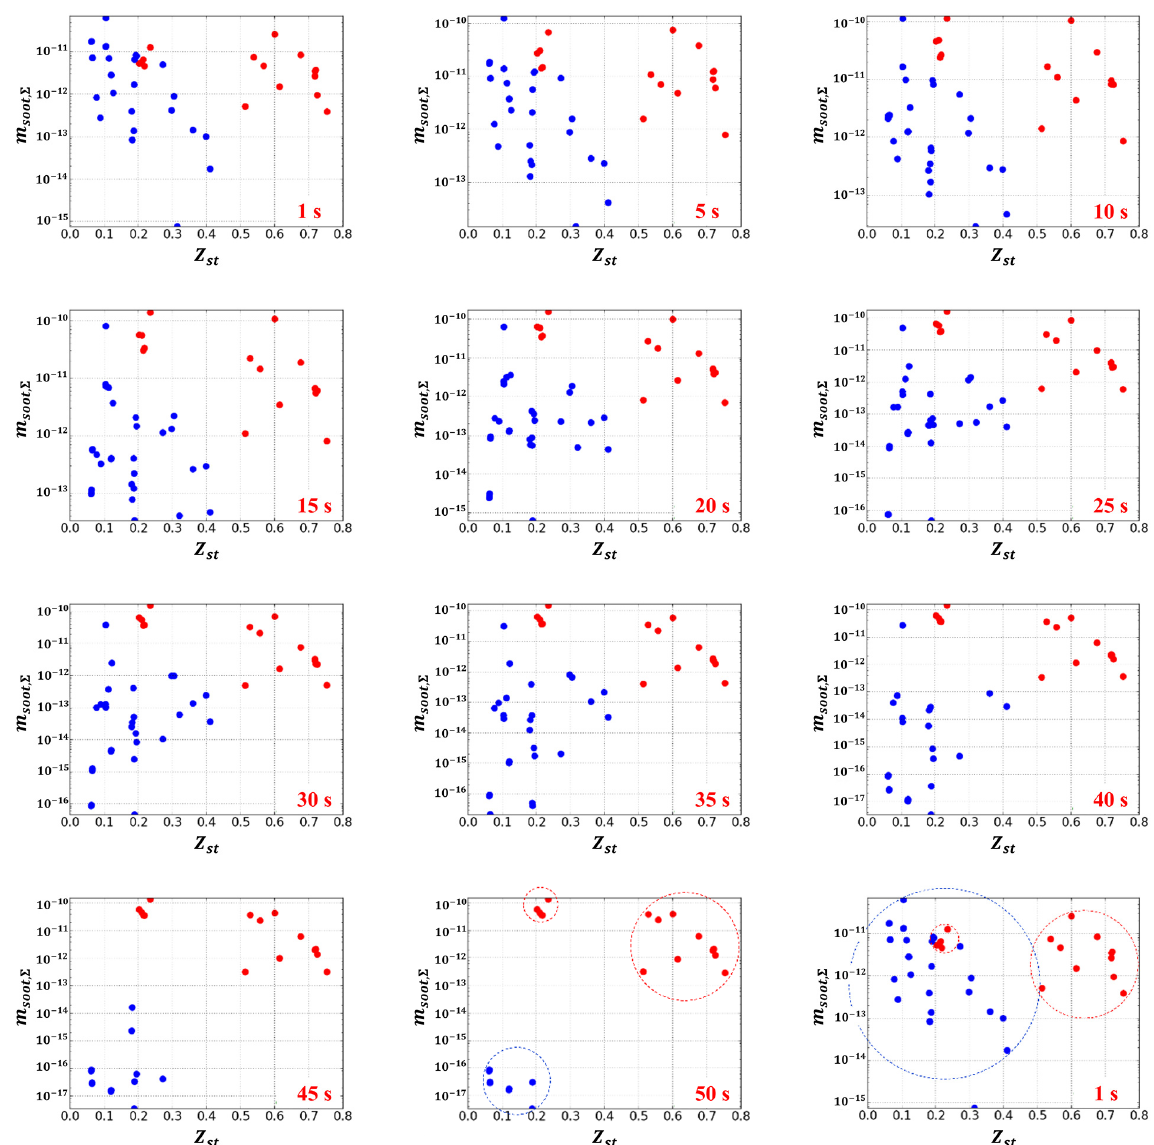
Figure 8. Dynamics of change in the calculated total soot mass m soot , Σ versus time for flames with different values of Z st . Normal flames are represented by blue dots, while inverse flames are represented by red